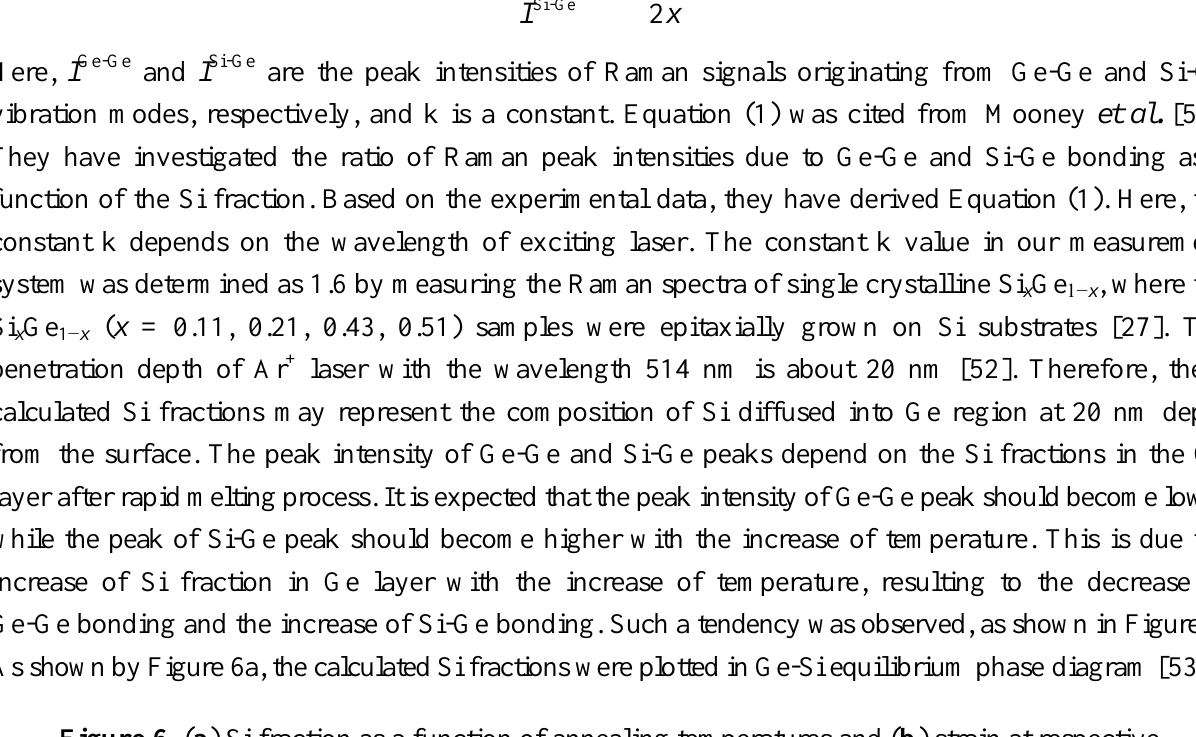
depth for different annealing